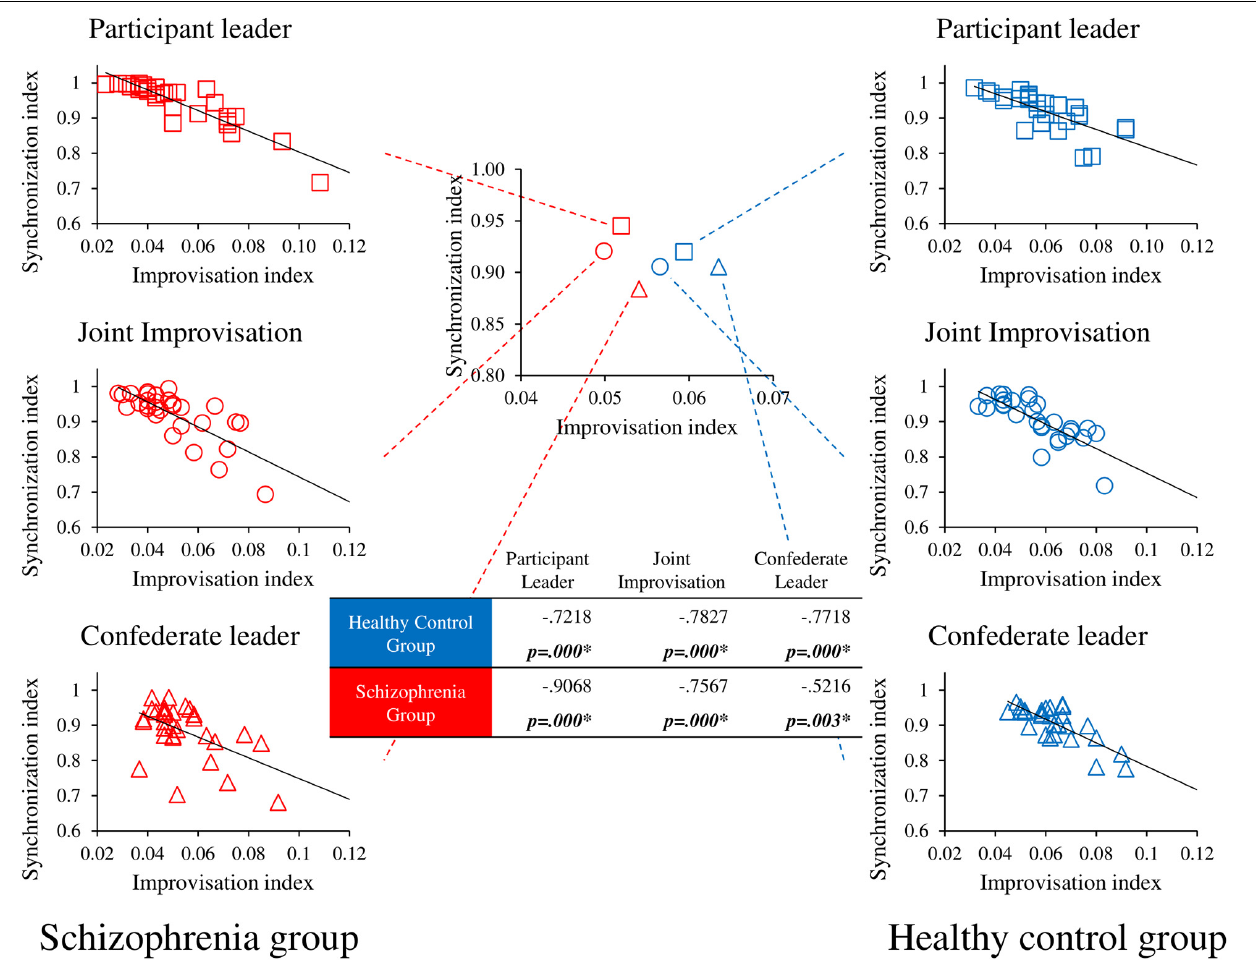
FIGURE 4 | Correlational analyses between socio-motor improvisation and socio-motor synchronization. r and p values are presented in the table for the correlation between Socio-motor improvisation and Socio-motor synchronization for each group in the three conditions. p values < 0.1 are represented in bold and * represents significant correlations < 0.05. Central figure represents the improvisation-synchronization trade-off for each group in each condition whereas peripheral figures details correlations for each condition in the schizophrenia group on the left side and the healthy control group on the right